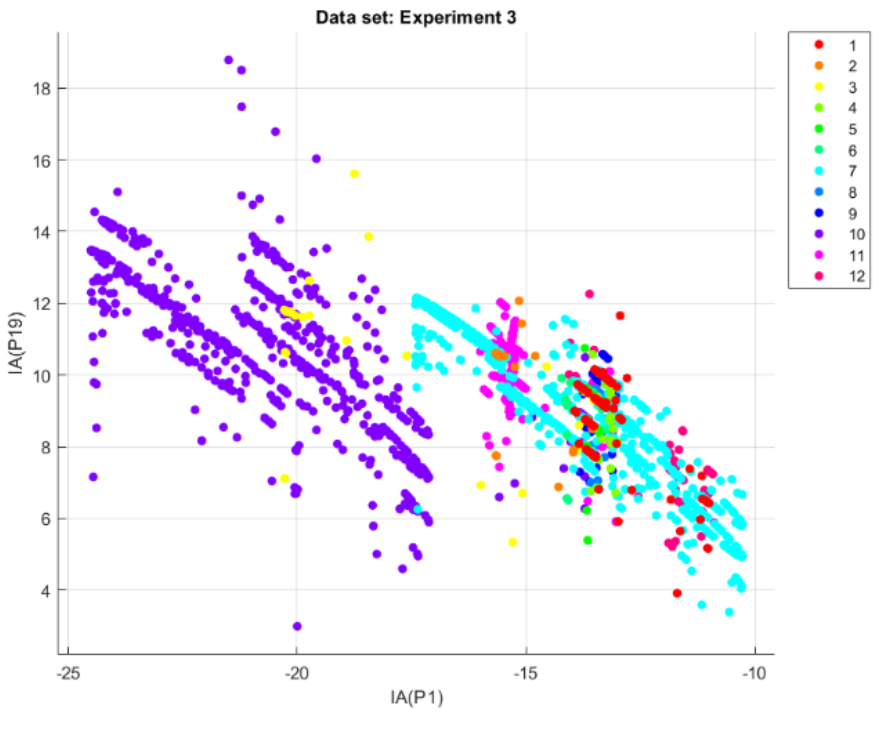
Figure 16. Data set of experiment 3.